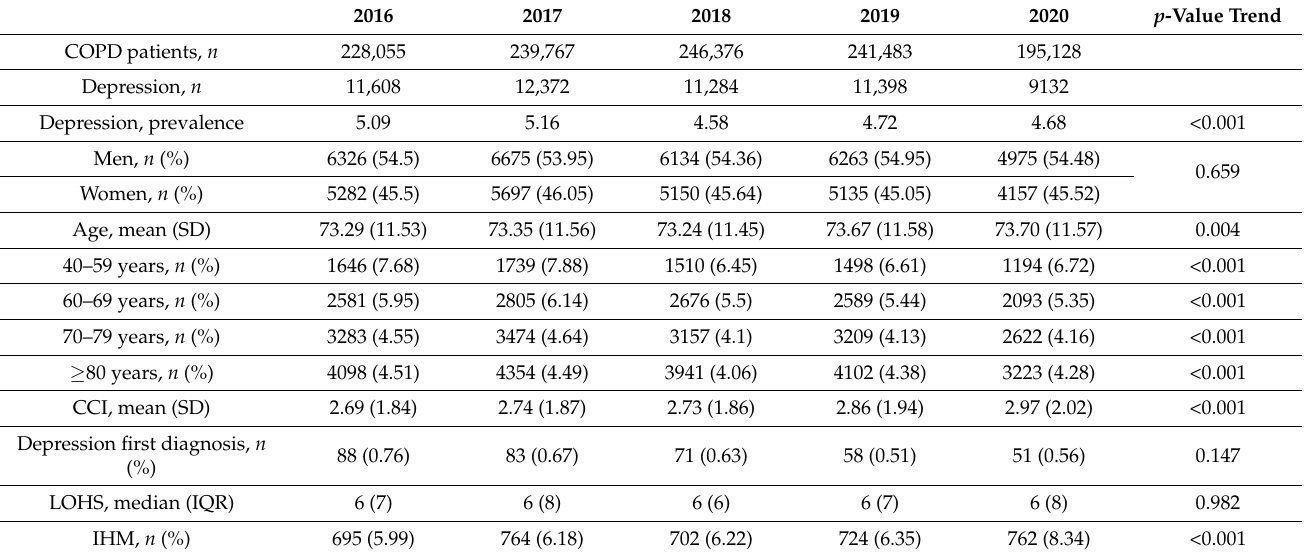
Table 1. Characteristics of patients with COPD suffering depression according to year from 2016